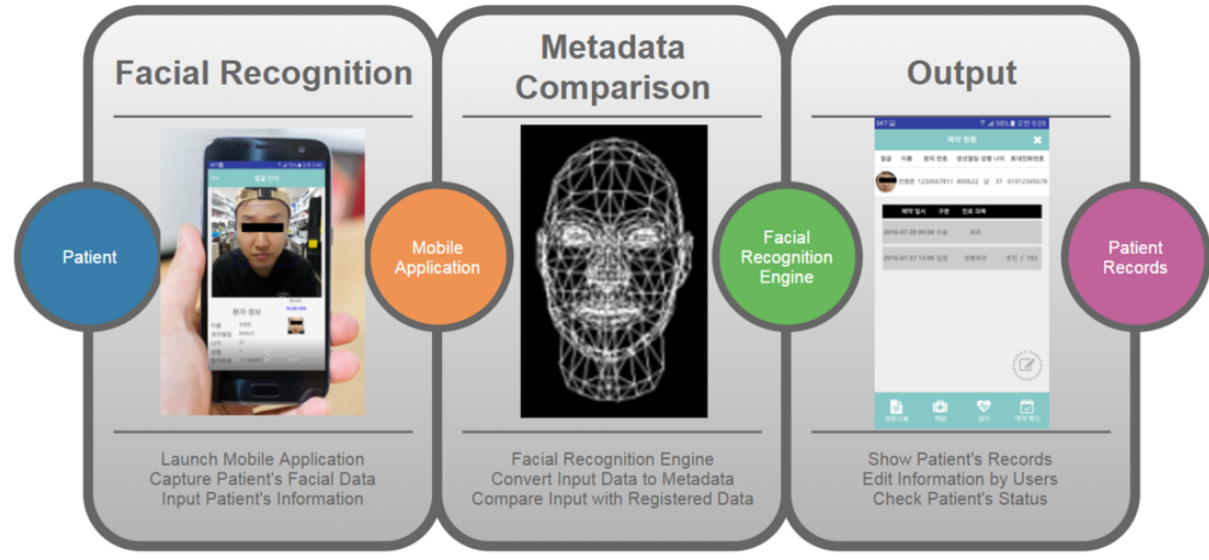
Figure 1. Process of facial recognition